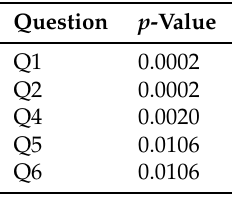
Table 7. p -value results obtained for each perception questionnaire